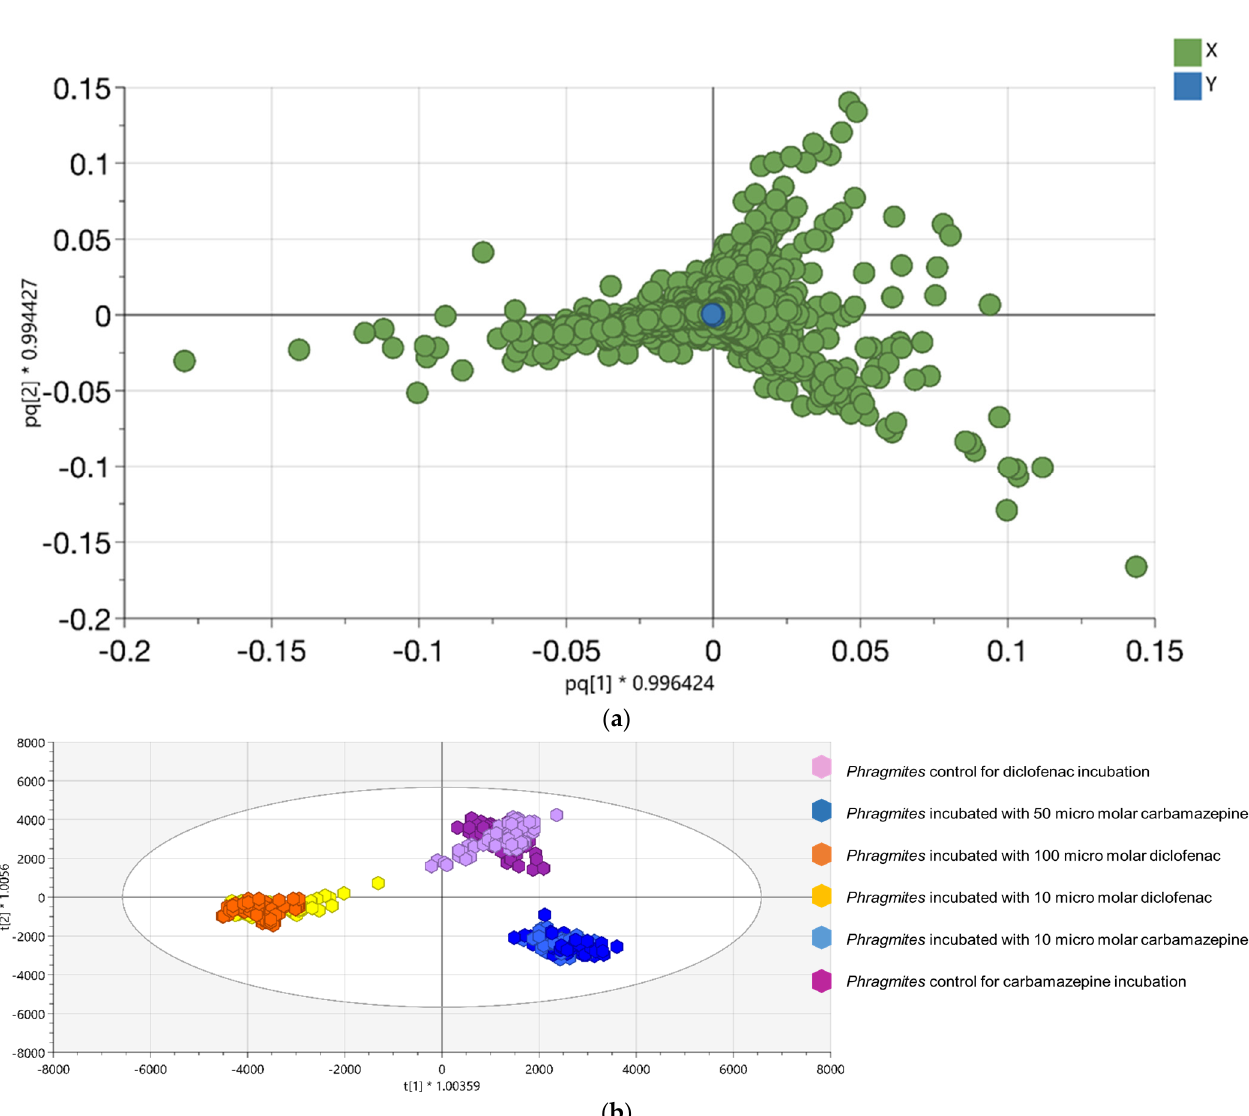
Figure 3. ( a ) The loading plot displays the relation between the different Phragmites australis samples and the chosen metabolite; ( b ) the OPLS-DA score plot of different Phragmites australis samples incubated with 10 and 50 µM carbamazepine, 10 and 100 µM diclofenac, individually. The confidence limit is 95%. For carbamazepine incubation the purple color represents the control group, the light blue represents a sample incubated with 10 µM carbamazepine and the blue color represents samples incubated with 50 µM carbamazepine. For diclofenac incubation the light purple color represents the control group, the yellow color represents samples incubated with 10 µM diclofenac and the orange color represents samples incubated with 100 µM diclofenac.